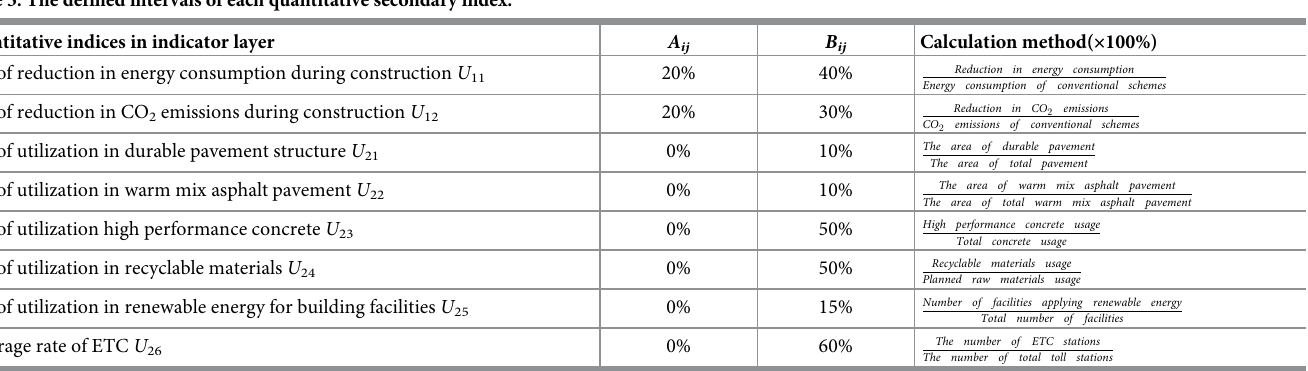
Table 5. The defined intervals of each quantitative secondary